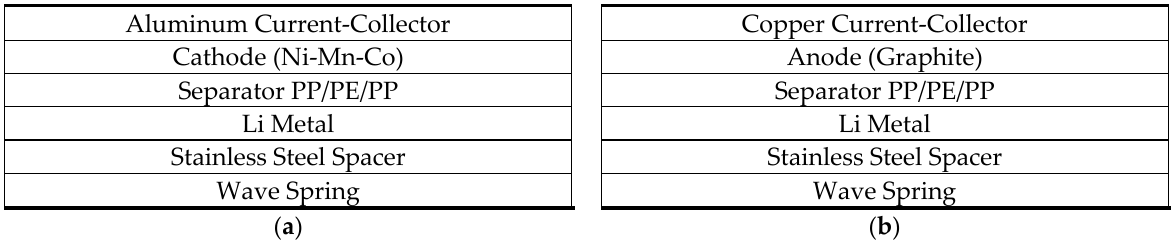
Figure 4. The assembly of half-cell LIBs, ( a ) cathode and ( b ) anode. To analyze the effect of chemical reactions during battery cycling on the CCs’ chemical compositions, the half-cells were opened after cycling to observe the reappearance of surface impurities on the CCs’ after testing using SEM and